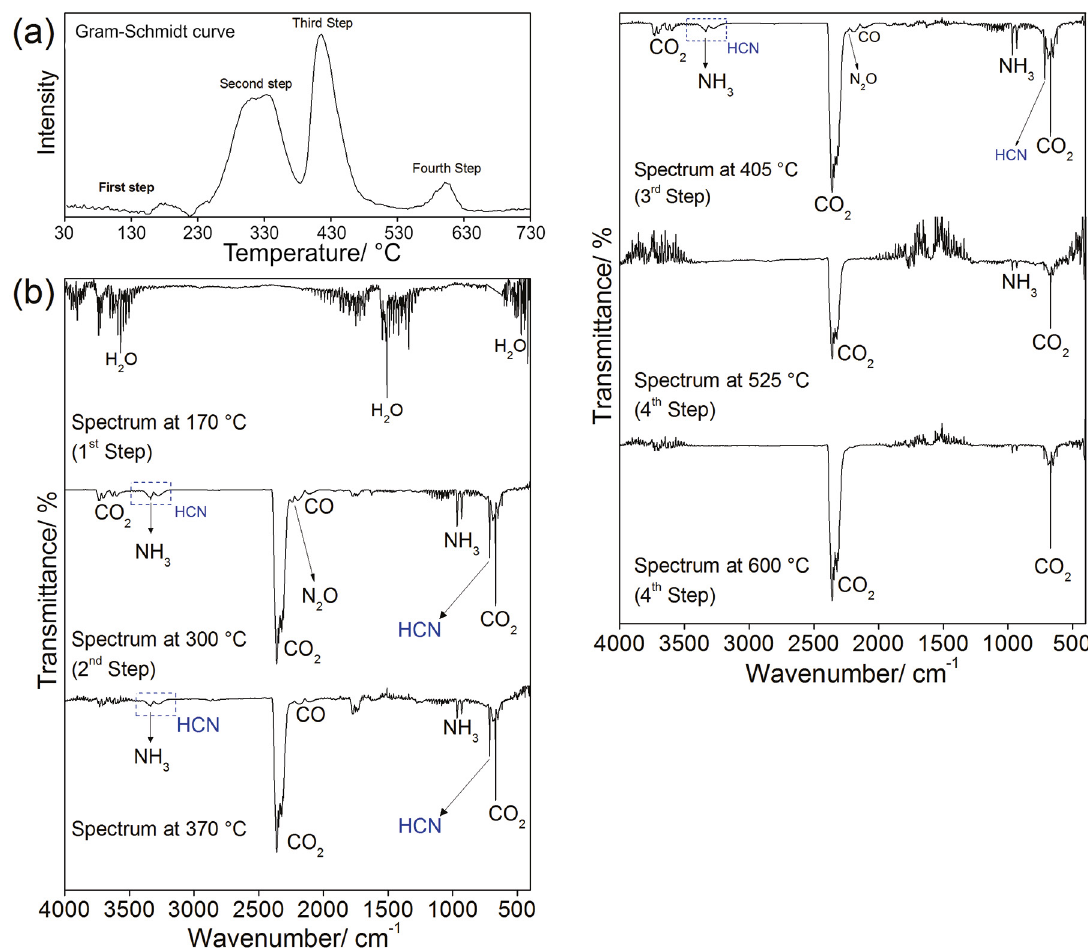
Figure 2. (a) Gram–Schmidt curve and (b) IR spectra of gaseous products evolved during the thermal decomposition of the yttrium complex.